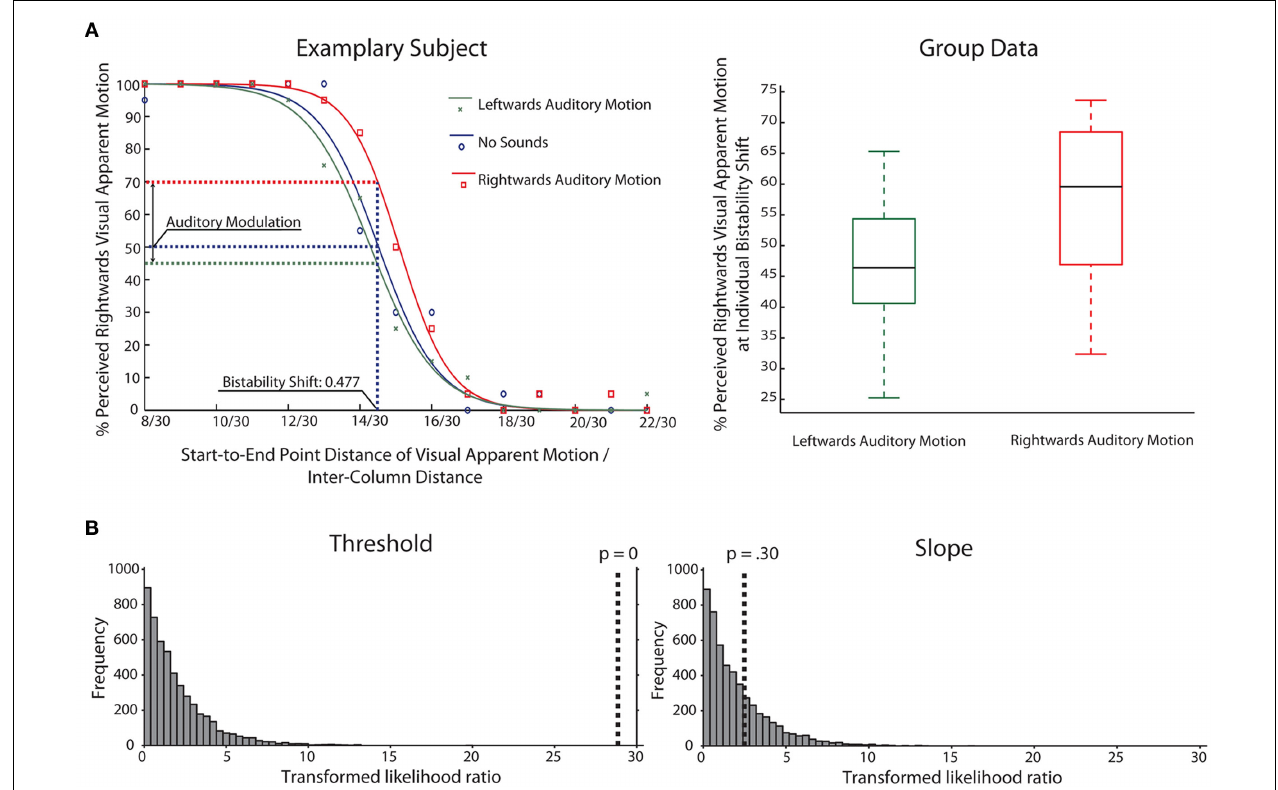
shift which was estimated on an individual level. (B) Results of bootstrapping analysis ( N = 5000) for group data comparing different models for thresholds and slopes in the three conditions (Leftward, No-Sound, Rightward).The histogram shows the distribution of likelihood ratios for the simulated data (see Materials and Methods for details).The dotted line indicates the likelihood ratio for the actual data.The results indicate that assuming varying thresholds for the three conditions is a more adequate model than a fixed threshold for all three conditions ( left panel ), whereas this is not the case for slope ( right panel